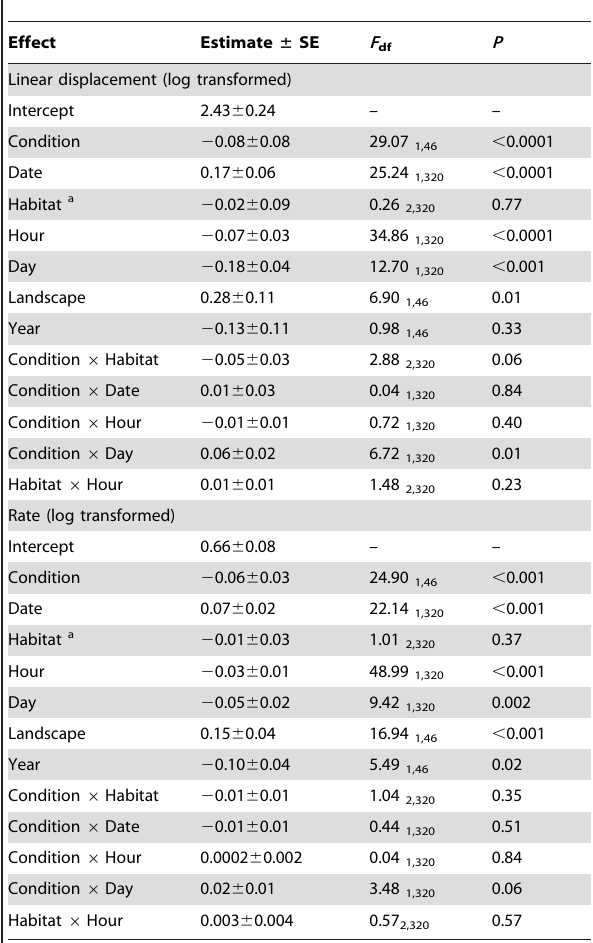
Table 3. Influence of endogenous and exogenous factors on migrant movement (linear displacement and movement rate).